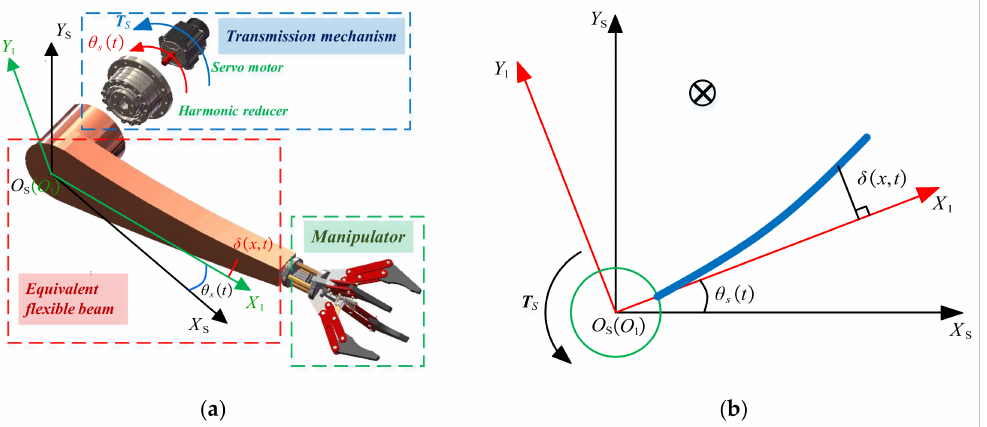
Figure 1. Schematic diagram of flexible load: ( a ) 3D model diagram; ( b ) schematic diagram of an equivalent flexible connecting